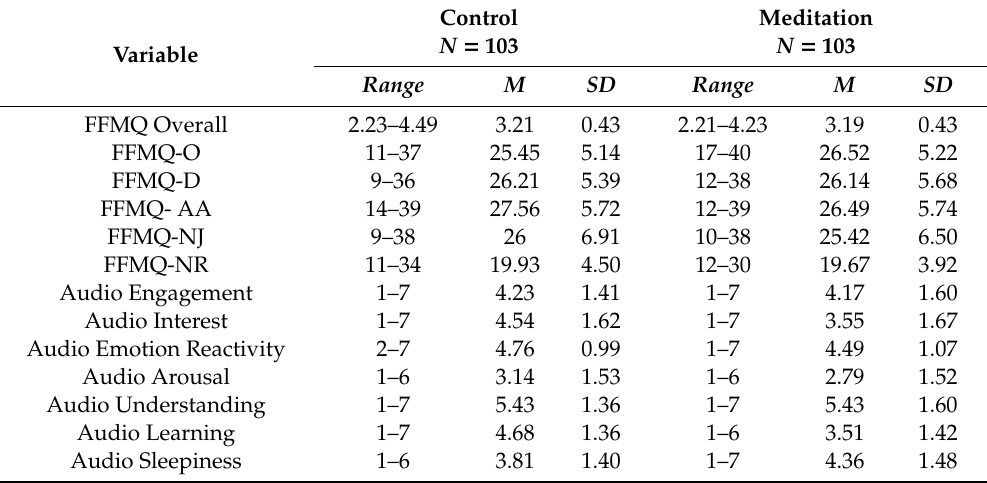
Table 1. Means and standard deviations of self-report battery by